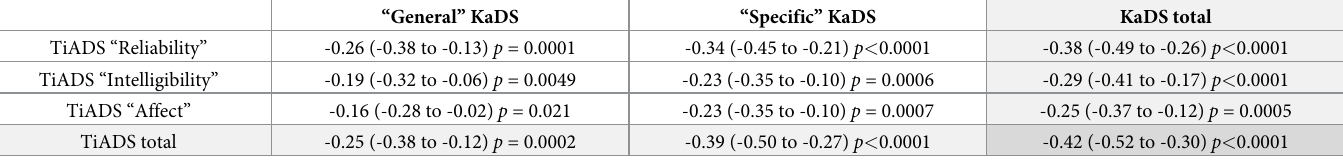
Table 4. The association between the subscales of knowledge about dietary supplements and trust in advertising them in the general public. The values presented include Pearson’s correlation coefficient (95% confidence intervals) and p -value. P -values for each of the comparisons between the correlation coefficients for a given KaD- S-TiADS subscale were higher than